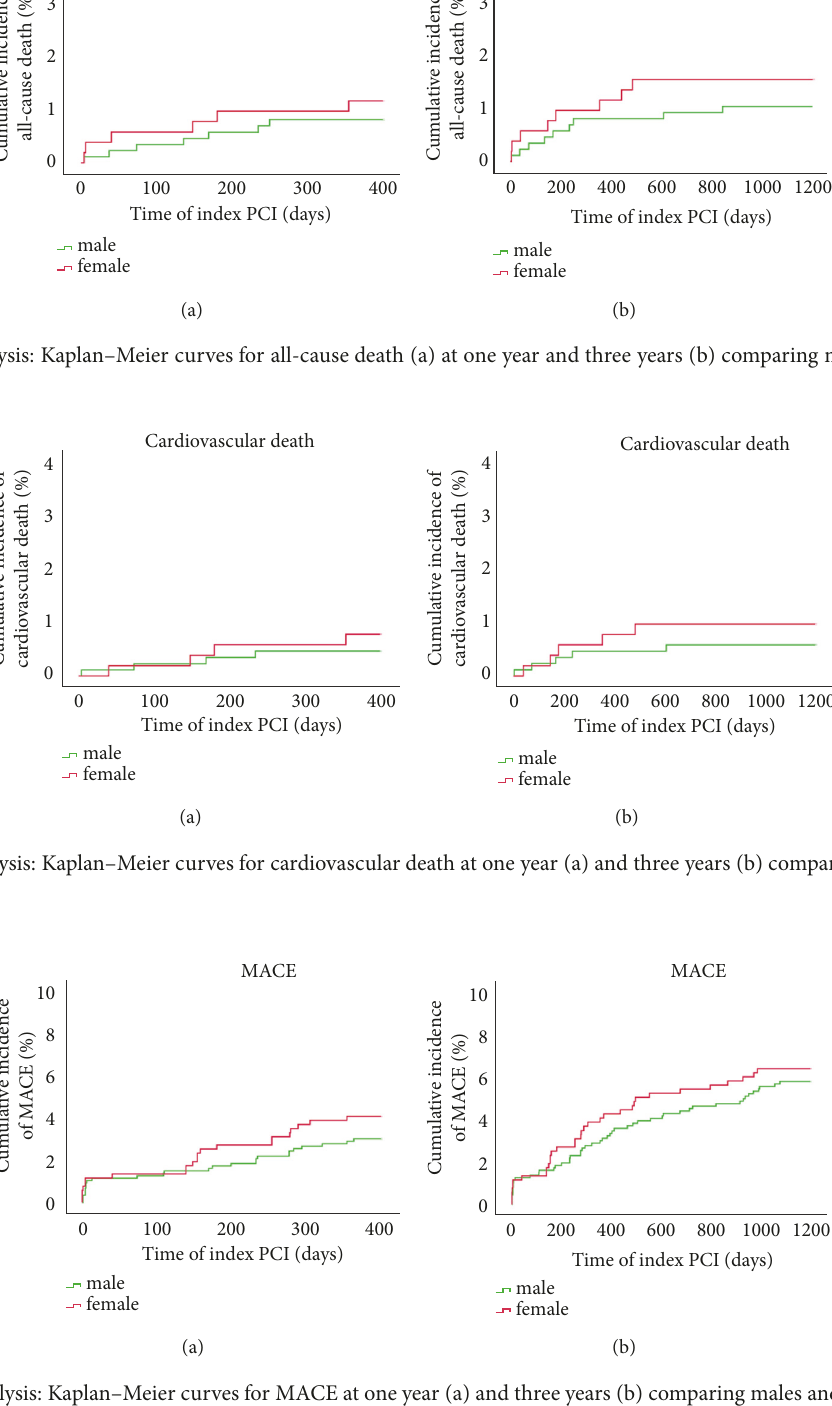
baseline variables and lesion characteristics were analyzed, unmeasured confounders could influence the observed